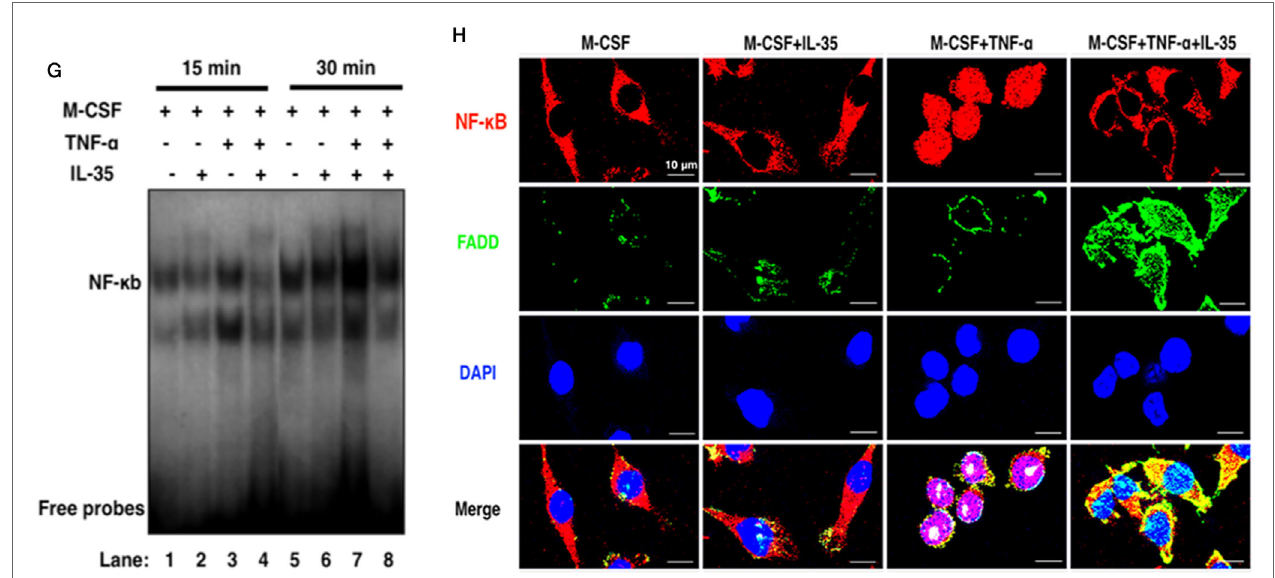
FigUre 4 | The effect of interleukin 35 (IL-35) on two pathway of TNF- α . (a,B) Phosphatase kinase antibody microarray (ARY003B, R&D systems) was used to analyze the effect of IL-35 on TNF- α -activated signal pathway. (c–e) Activation of NF- κ B, MAPK, and JAK/STAT induced by TNF- α in the presence or absence of IL-35. (F) Molecules in TNFR1-TNF receptor-associated death domain-Fas-associated death domain (FADD)-caspase 3 pathway were detected by western blot. (g) Electrophoretic mobility shift assay performed to measure the DNA binding activity of NF- κ g were detected in different group. (h) The effect of IL-35 on the expressions of p65 and FADD in bone marrow monocytess with or without TNF- α were detected by immunofluorescence staining. * p < 0.05, ** p <